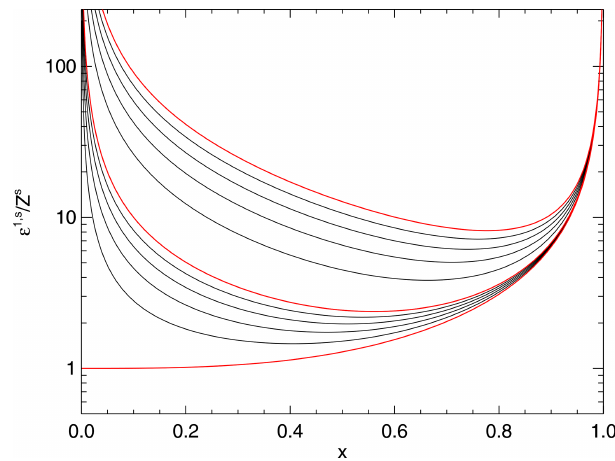
Figure 8. The error due to sensor-specific disturbances and to the quadrupole disturbance introduced by PiCoG dipole disturbance correction. The x axis represents the position x = r t /r s of the in- board sensor relative to the outboard sensor. Sensor noise is the same for both sensors. Each line corresponds to a fixed value of the quadrupole disturbance at the outboard position. Red lines, bot- tom to top: b s q = (0, 1 and 10) × Z s . The black lines in between cor- respond to (0.2, 0.4, 0.6, and 0.8) × Z s and (2, 4, 6, and 8) × Z s ,